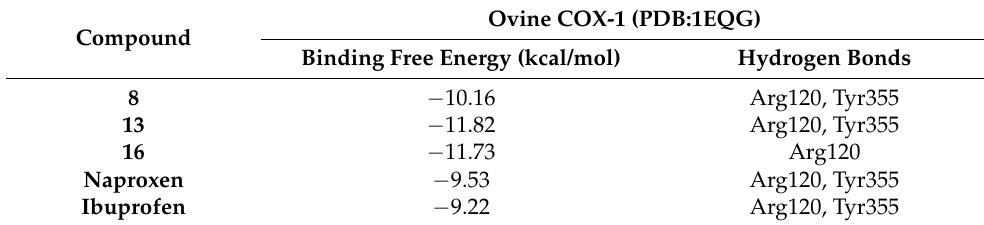
Table 4. Docking results and interacting residues against COX-1.